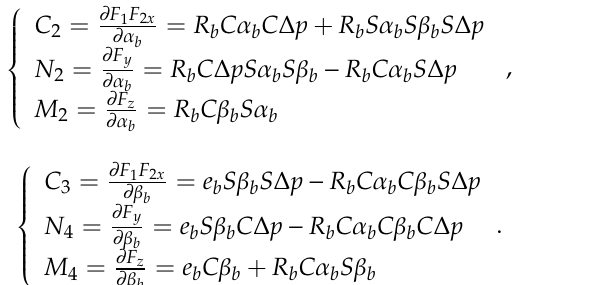
Figure 8. Change surface map of C 3 . ( a ) corresponds to β b less than 0, ( b ) corresponds to β b greater than 0.